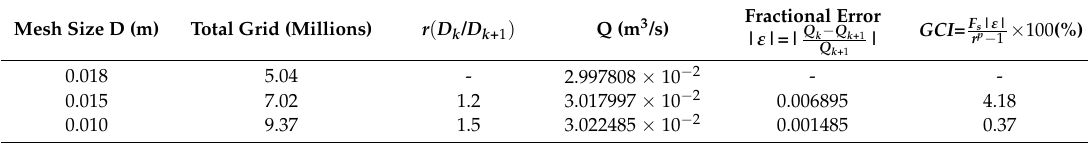
Table 2. GCI calculation results.